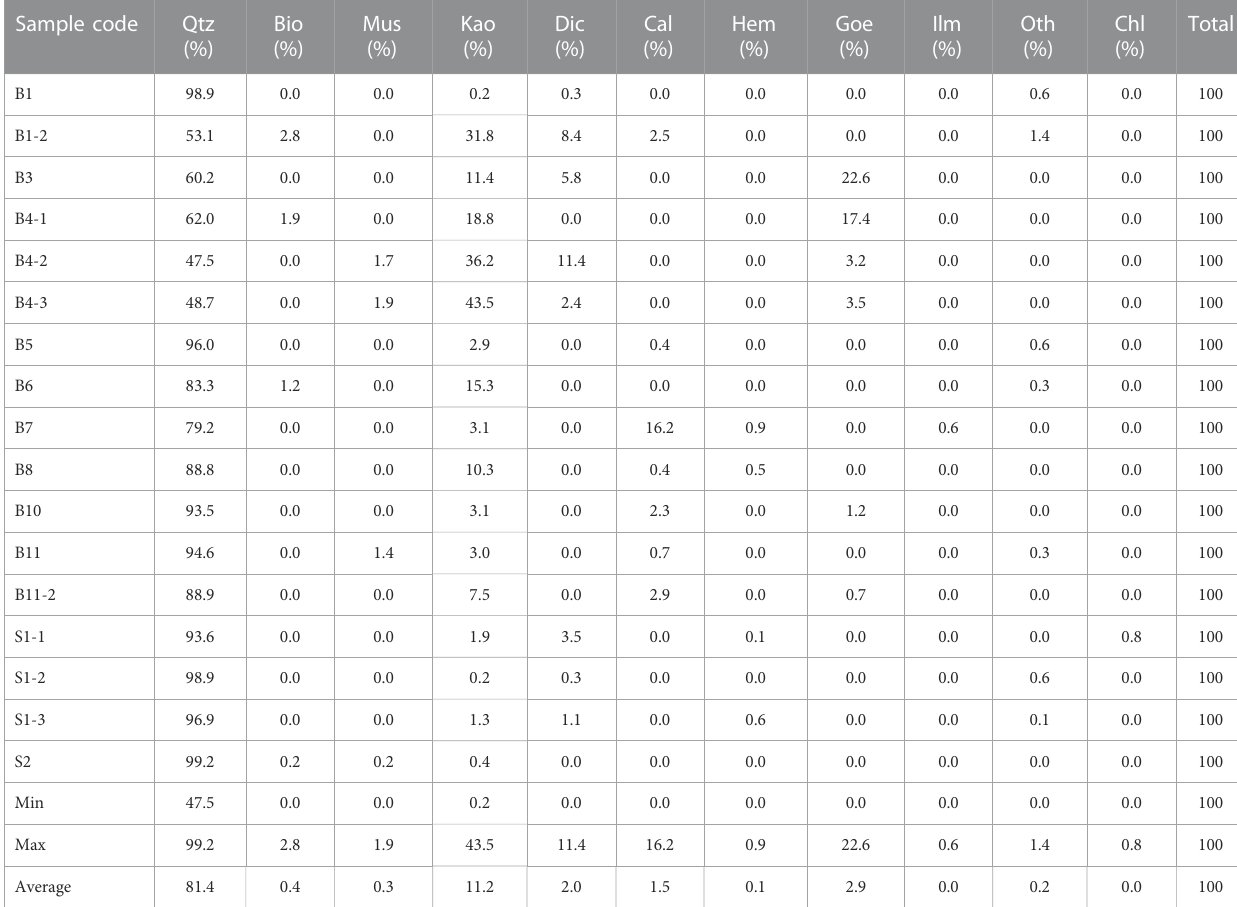
TABLE 2 Bulk XRD results for the studied Qasim sandstones. Sample